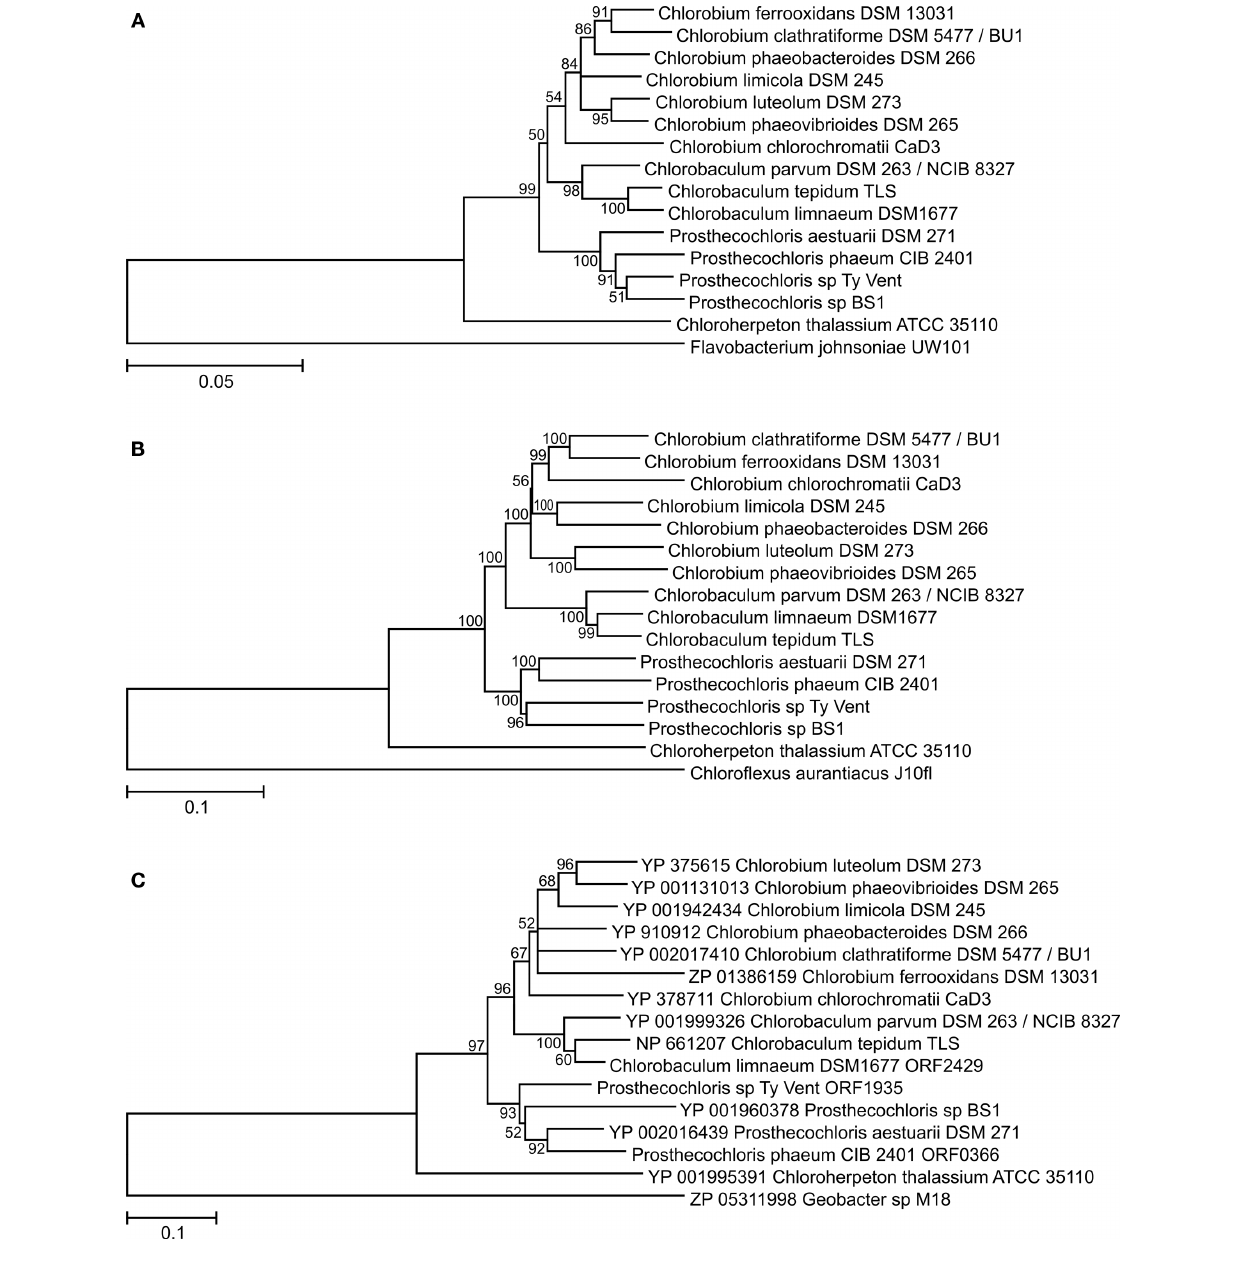
Figure 2 | Phylogenetic trees of ribosomal rNA and core metabolism enzymes of gSB. (A) SSU rRNA gene; rooted with Flavobacterium johnsoniae . (B) Concatenation of the following house-keeping proteins (with the protein name in Cba. tepidum TLS in parenthesis): RNA polymerase subunit beta (RpoB/CT0155), alanyl-tRNA synthetase (AlaS/CT0166), translation initiation factor IF-2 (InfB/CT0241), DNA gyrase subunit B (GyrB/CT2263), molecular chaperone DnaK (CT0643), F F ATP synthase subunit α (AtpA/CT2033), 0 1 preprotein translocase subunit SecY (CT2169), cell division protein FtsZ (CT0030), phospho- N -acetylmuramoyl-pentapeptide-transferase